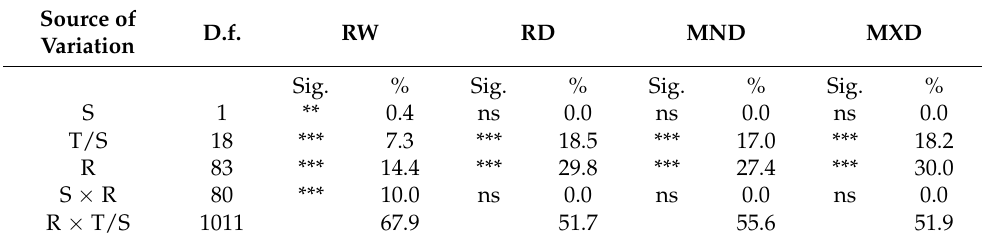
Table 5. Summary of the analysis of variance for ring width (RW), mean ring density (RD), mini- mum ring density (MND) and maximum ring density (MXD), showing their significance (Sig) and percentage of total variation due to each source of variation (%). Source of D.f. RW RD MND MXD Variation Sig. %